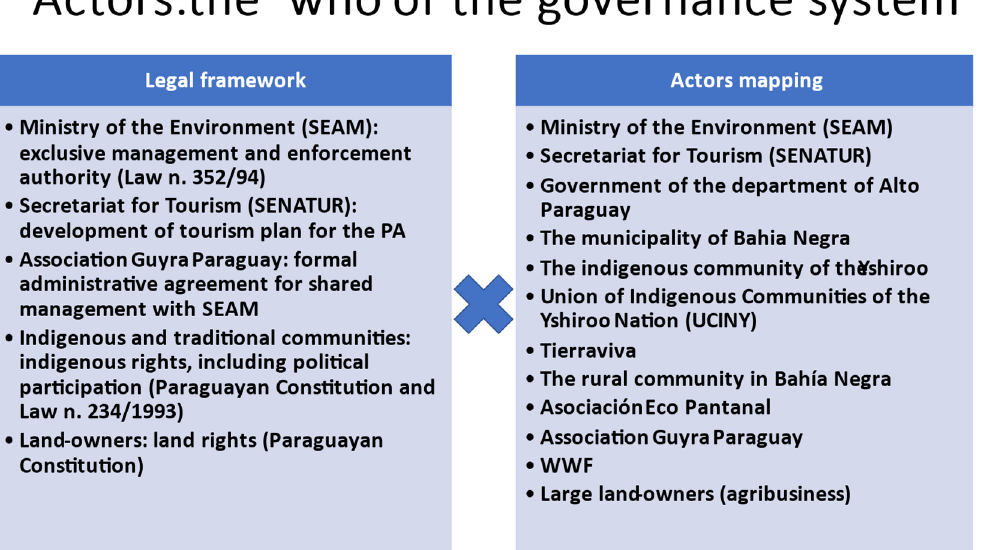
Figure 6. The actors (the “who”) of the RNNP governance system. “The entire region is characterized by the absence of the state” (PS3).